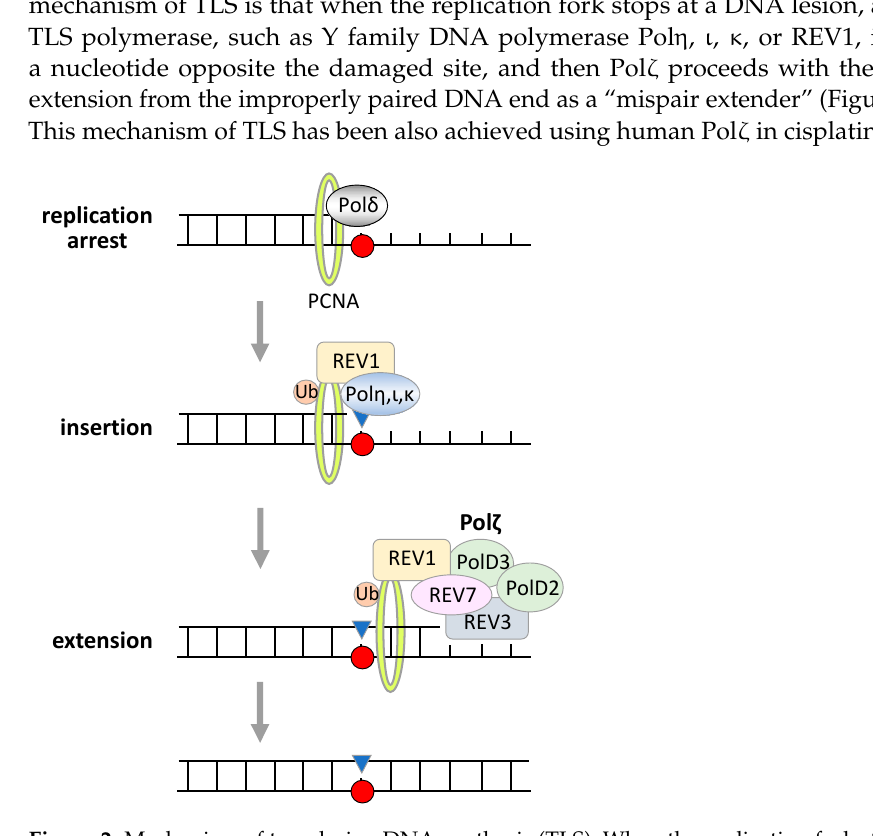
Figure 2. Mechanism of translesion DNA synthesis (TLS). When the replication fork stops at a DNA lesion (replication arrest), REV1 binds to monoubiquitinated proliferating cell nuclear antigen (PCNA) at the lesion and recruits inserter polymerases Pol η , ι , and κ to the damaged site to incorporate a nucleotide opposite the damaged site (insertion). Then, REV1 recruits Pol ζ via interaction with REV7 or PolD3, and Pol ζ proceeds with the subsequent extension from the improperly paired DNA end (extention). Finally, TLS completes without removing the damage. Ub, ubiquitin.